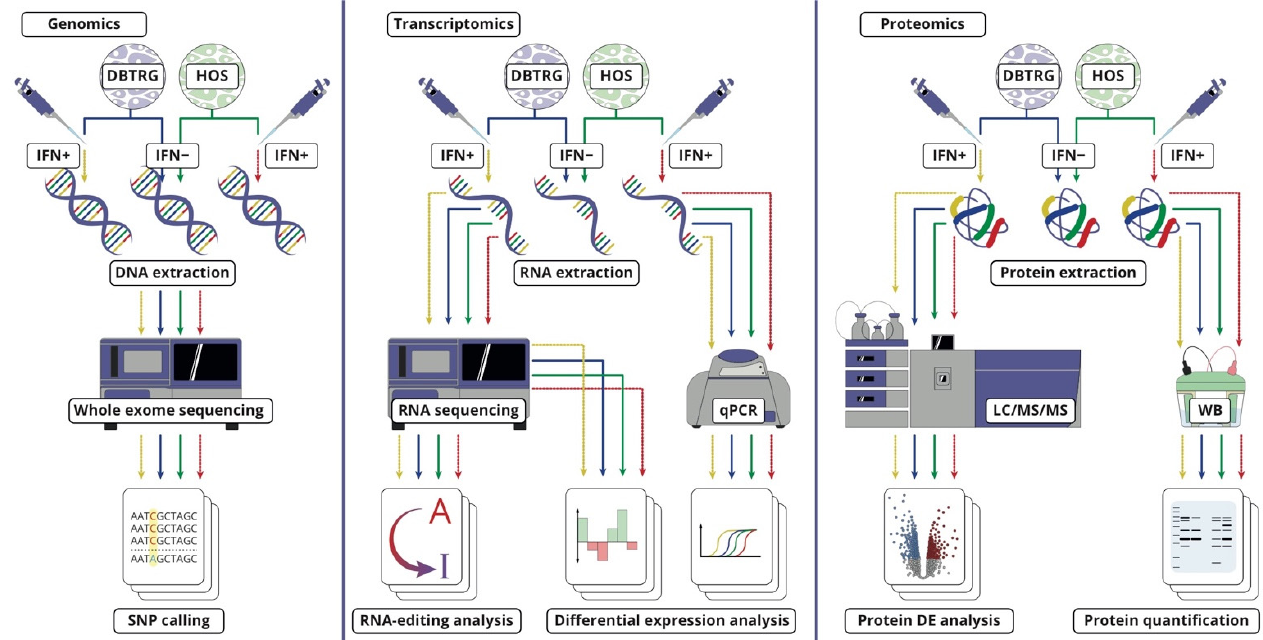
Figure 2. Multiomic workflow of this study. Two cell lines, DBTRG − 05MG and HOS, were analyzed at the genomic, transcriptomic, and proteomic levels before and after type I interferon treatment, which protected the former cell line from VSV infection and failed to protect the other one.